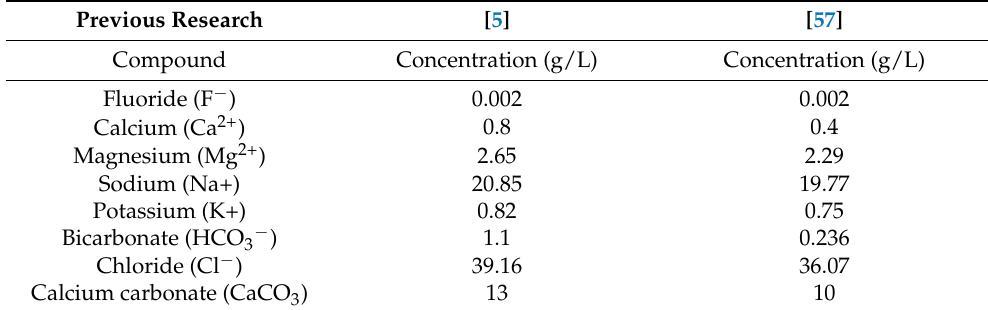
Table 5. Composition of wastewater from desalination plants used in previous studies.